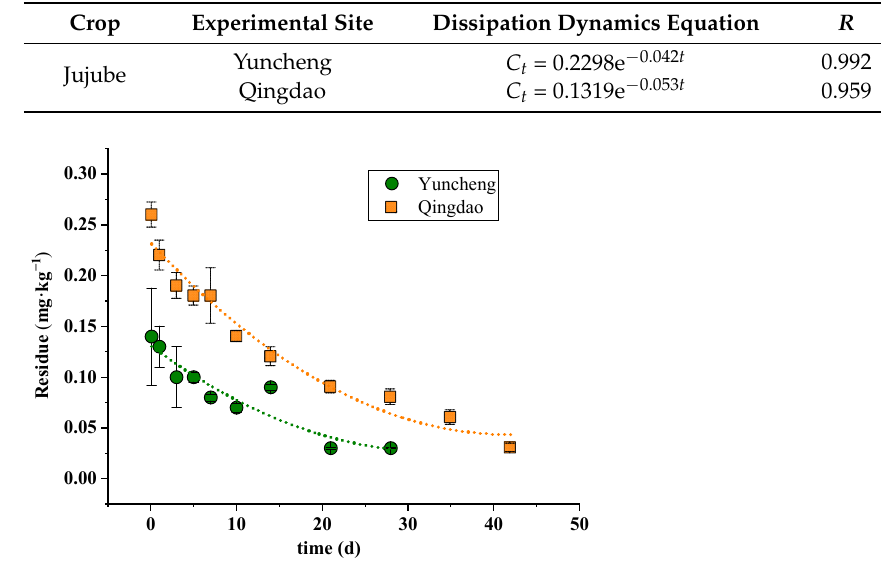
Figure 3. Dissipation dynamic curve of difenoconazole in jujube.